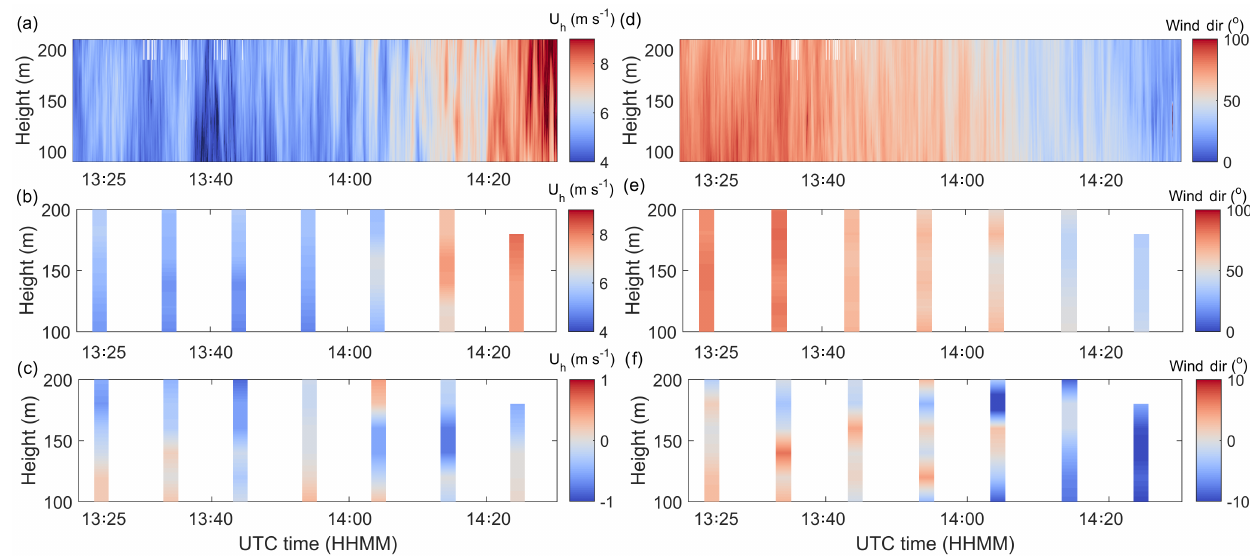
Figure 10. Intercomparison between radar and lidar virtual-tower measurements: (a) horizontal wind speed U h (ms − 1 ) retrieved with dual- Doppler radar; (b) horizontal wind speed U h (ms − 1 ) retrieved with triple-Doppler lidar; (c) difference in horizontal wind speed U h (ms − 1 ) between lidar and radar data; (d) wind direction retrieved from dual-Doppler radar; (e) wind direction retrieved from triple-Doppler lidar; (f) difference in wind direction between lidar and radar data.